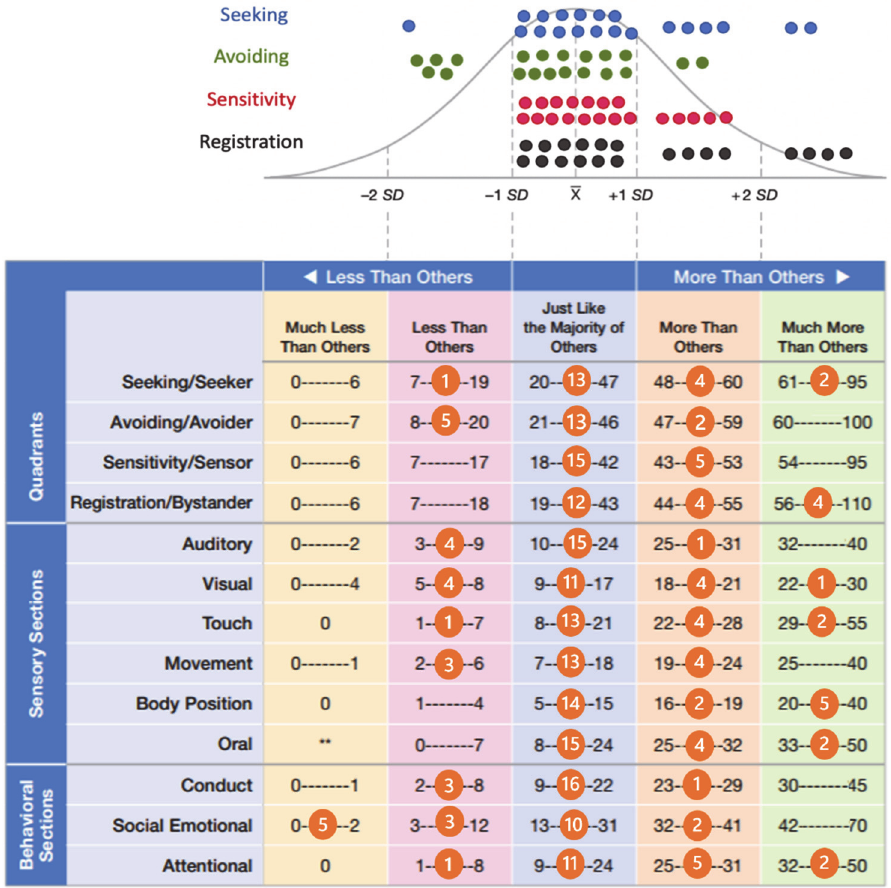
Figure 3. The distribution of the four different sensory processing patterns in the population is shown at the top of the figure. At the bottom of the figure, the number of children falling within the different categories were entered into the C-SP2 scoring sheet.